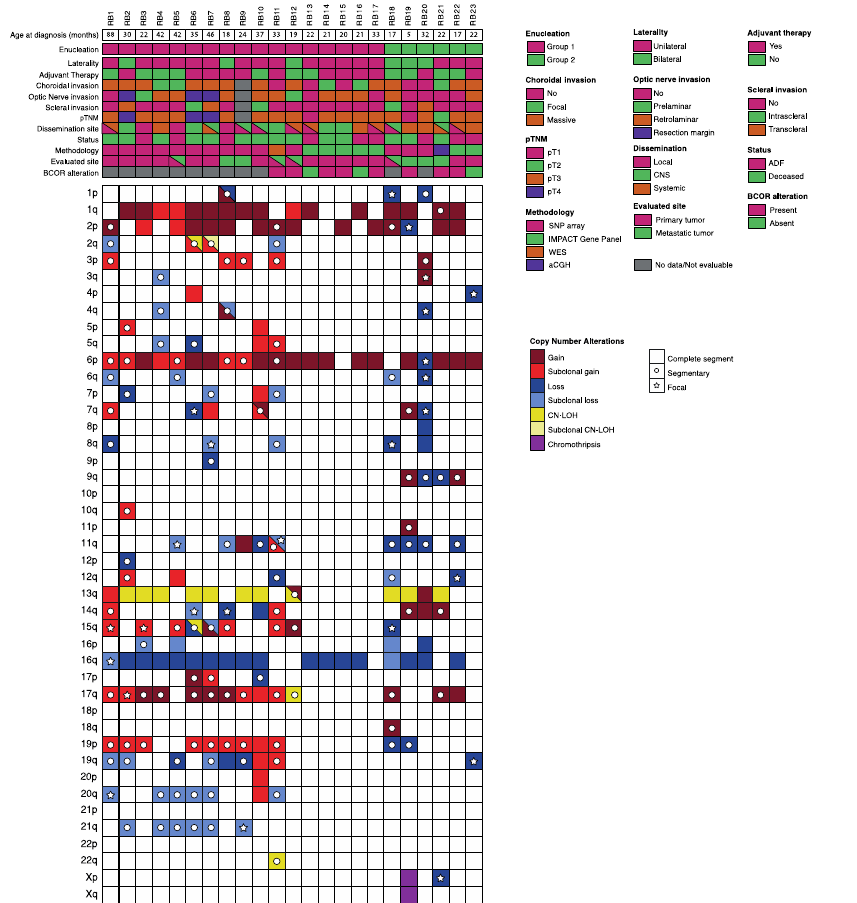
Figure 1. Clinical, pathologic, and genetic features of the 23 retinoblastoma patients. Each column represents an individual sample, and the rectangular boxes correspond to the status of each of the main characteristics depicted. Boxes are parti- tioned if more than one relevant feature coexists. For each clinical feature, the corresponding legend is represented on the left of the figure. For copy number alterations, gains are shown in red, blue represents losses, yellow is for CN-LOH and purple for chromothripsis, while the intensity of the color shade is proportional to the value of the log-ratio (LRR). In addition, full coloring means the copy number alteration comprises the whole segment (>90% of the arm), whereas a circle means part of the segment is altered and a star means it is a focal alteration (<15 genes). In cases where samples from primary site and metastatic site were available (patients RB5, RB11, RB12 and RB18), only the primary tumor results were